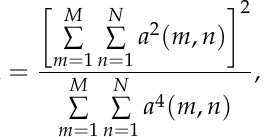
Figure 4. The 200 extracted low-frequency clutters from Chang’E-3 LPR data and its average fre- quency amplitude spectrum. ( a ) The extracted low-frequency clutters. ( b ) Average frequency am- plitude spectrum of the signals in (a).